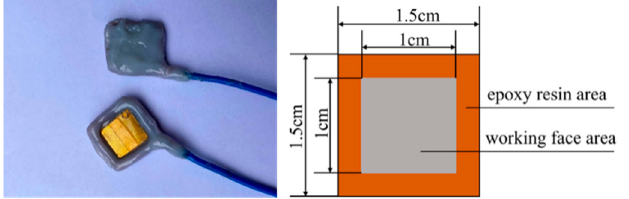
Figure 1. Schematic diagram of the physical dimensions and size of the X70 steel sample.